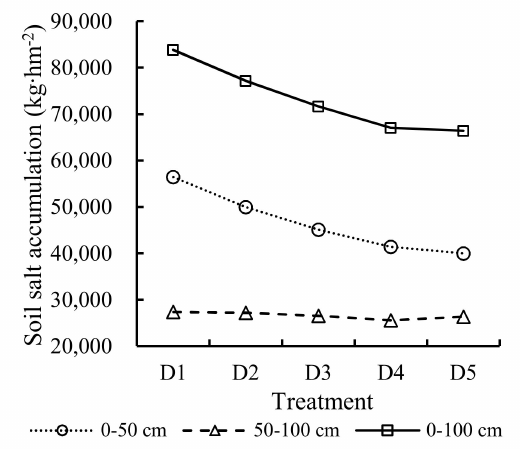
Figure 7. Soil salt accumulation inside the film in 2017.